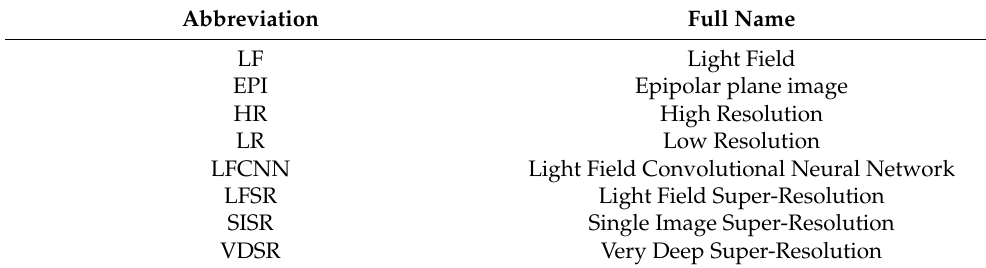
Table 1. Full names of